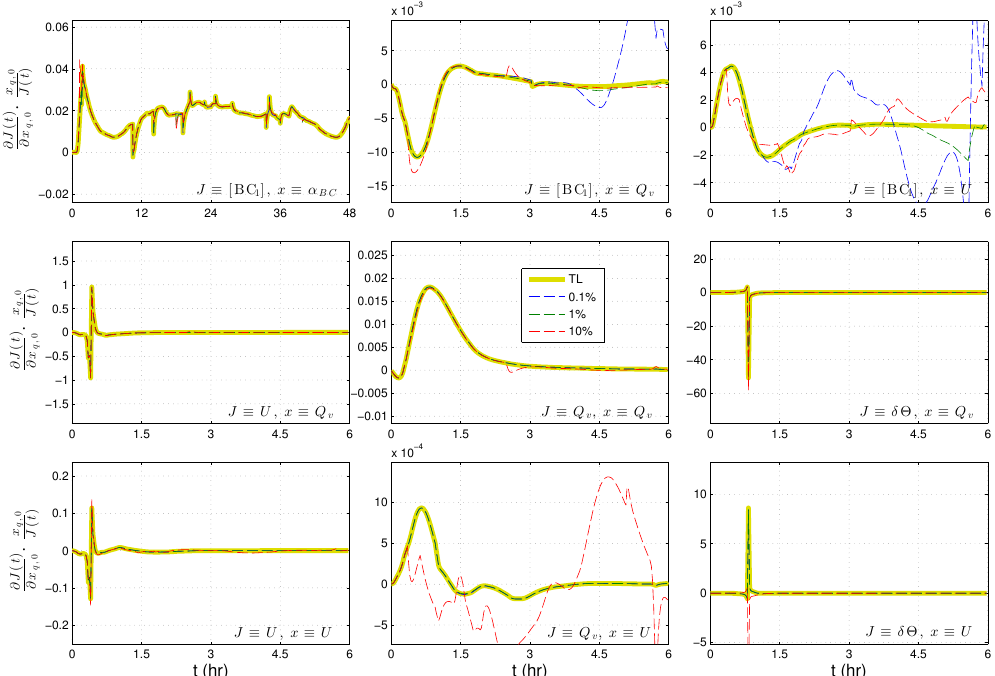
Figure 4. Fully normalized time variant sensitivities calculated with the TLM with second-order checkpointing and with multiple finite difference perturbation sizes. Each plot is for a single pair of source and receptor locations, q and p